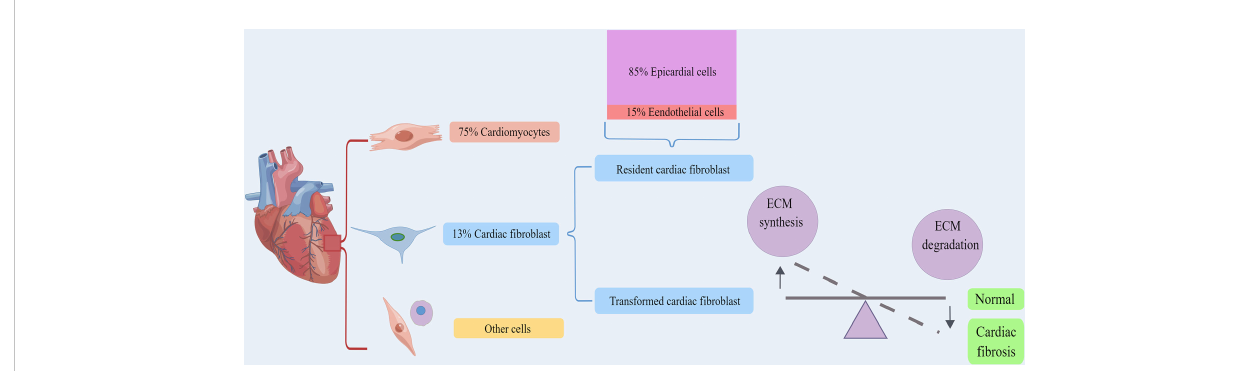
FIGURE 2 The origin and physiological function of cardiac fi broblasts. Cardiomyocytes account for about 75% of the volume of myocardium, and fi broblasts accounted for about 13%. Cardiac fi broblasts including resident cardiac fi broblast and transformed cardiac fi broblast. Approximately 85% of cardiac fi broblasts come from epicardial cells, while the other 15% are derived from endothelial cells. Both of them could serve to maintain the structural integrity of the ECM network and regulate collagen renewal. By Figdraw. ECM, extracellular